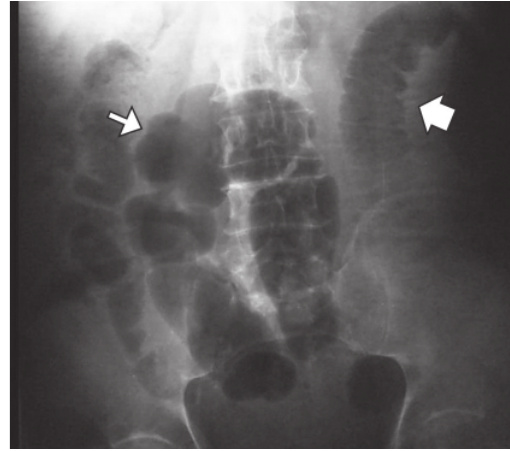
Figure 1 – Radiograph of the abdomen in the supine position, showing the distension of the jejunum flaps (narrow arrow) and “pile of the coins” sign (wide arrow) – both signs of intestinal